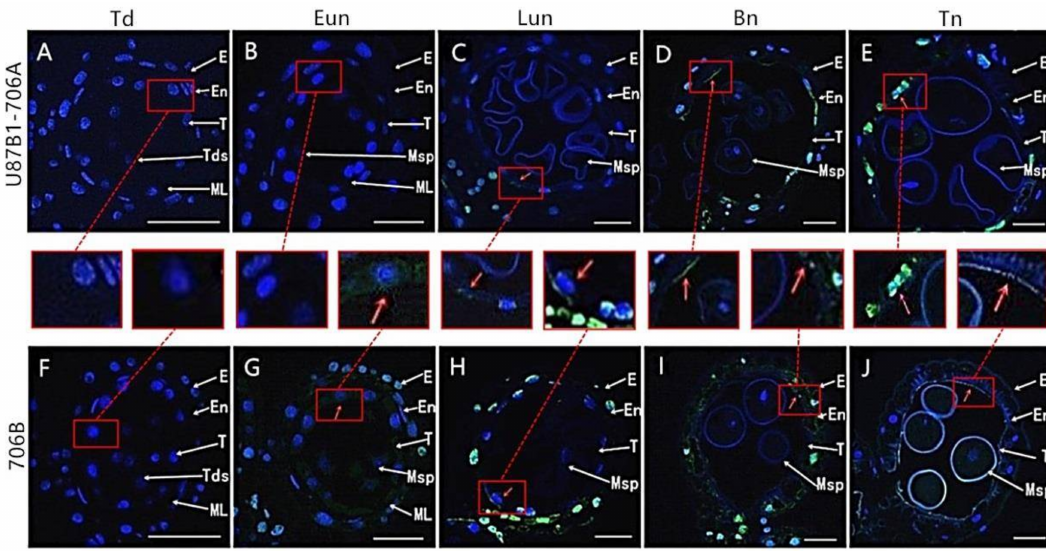
Figure 4. TUNEL assays to detect anther tapetum PCD in U87B1-706A ( A – E ) and 706B ( F – J ) during different developmental stages. ( A , F ) Td, tetrad stage; ( B , G ) Eun, early uninucleate stage; ( C , H ) Lun, late uninucleate stage; ( D , I ) Bn, binucleate stage; and ( E , J ) Tn, trinucleate stage. E, epidermis; En, endothecium; ML, middle layer; T, tapetum; Tds, tetrads; Msp, microspores. The green fluorescence denoted by the red arrows indicates nuclei with TUNEL-positive staining. To make green fluorescence visible, the red square shows enlarged example. Scale bars are 50 µ m in ( A – J